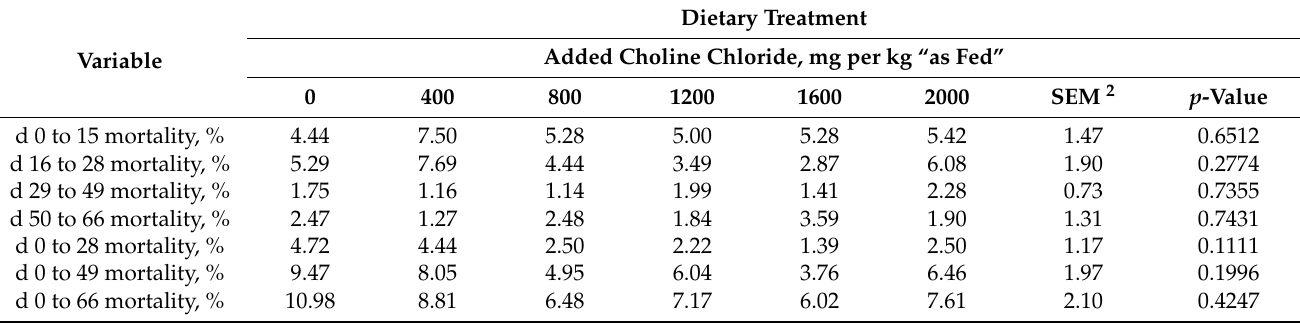
Table 4. Effect of choline chloride supplementation on broiler mortality from day 0 to 66 1